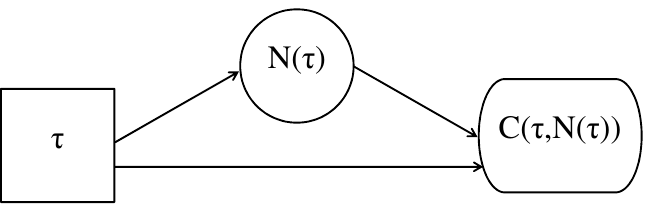
Figure 2. Influence diagram (ID) representation of a single-period replacement problem.